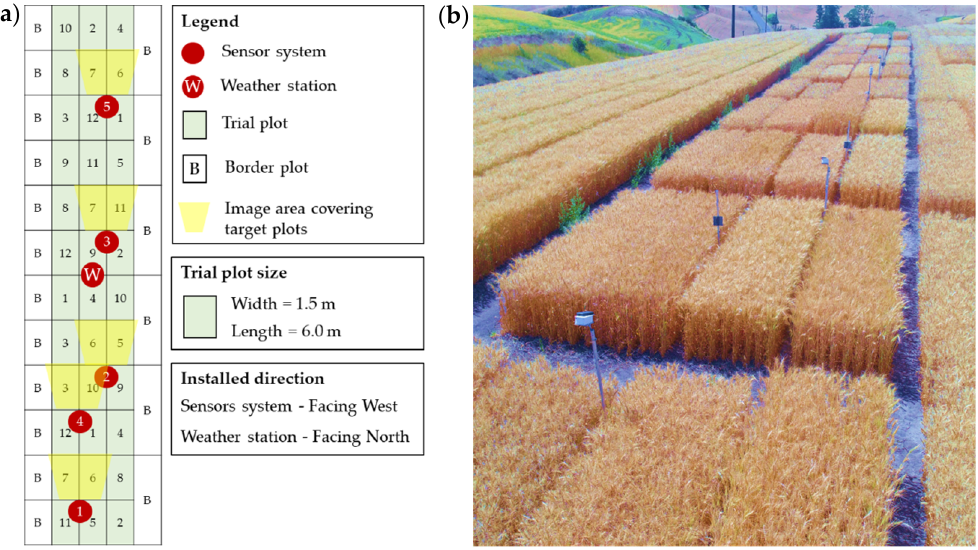
Figure 3. Spring wheat field trials. ( a ) Installation map, and ( b ) sensor system on the field. The sensors were installed facing toward the west side, and the cameras were set at 1.7 m above ground level (AGL) and 1.9 m away from the targeted plot boundary (Figure 4), and oriented 50–60° downward from a vertical plane to focus on the wheat plot for the growth stages from heading to maturity. In this study, the camera was adjusted to capture two targeted plots at the left and right sides of the reference panels. The distance between the reference panel stand and the camera stand was ~4.2 m (nearly the center of the two targeted plots). Additionally, the weather station was installed at 1.8 m AGL at the center of the field. The cameras, reference panels, and the weather station, were mounted on the aluminum pipes.